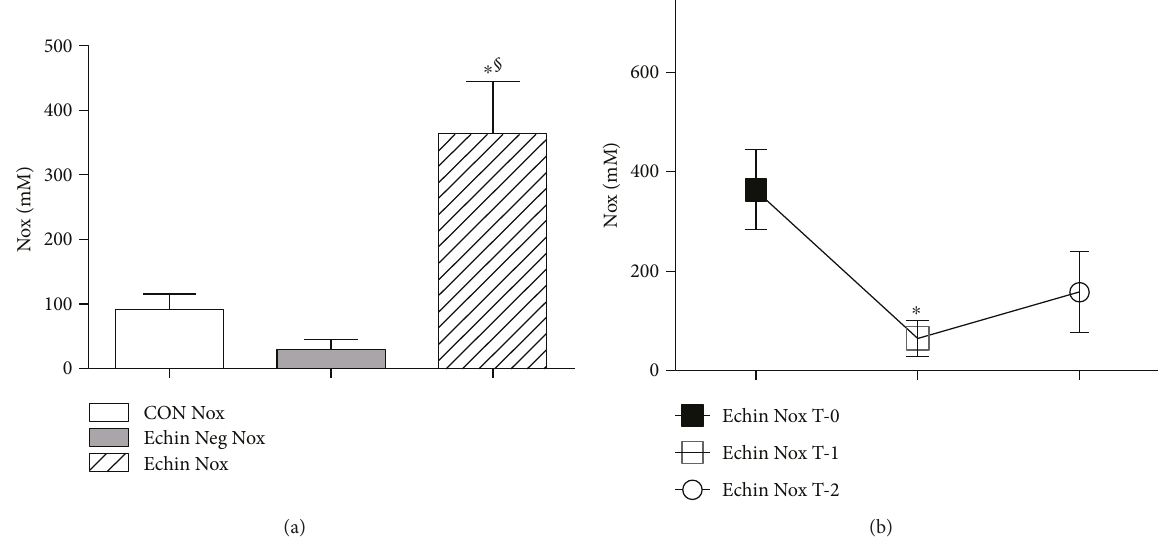
Figure 6: (a) Serum levels of Nox showed a signi fi cant increase ( p < 0 05 ) compared to corresponding serum concentrations found in healthy controls and Echinococcus -negative patients. Values are expressed as mean ± SEM. ∗ p < 0 05 versus CON; § p < 0 05 versus Echin Neg, after ANOVA and Fisher PLSD test. (b) Signi fi cant decline in the concentrations of nitric oxide metabolites in parasite-infected patients one week after surgery (time T-1) ( p < 0 05 ) compared with the levels found in patients before any therapy (time T-0); however, 1-2 months after therapy (time T-2), such nitric oxide metabolites exhibited a light increase.